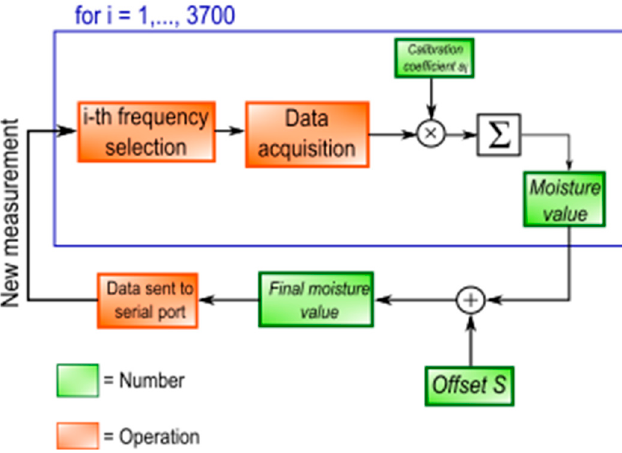
Figure 5. Moisture calculation in the MCU.